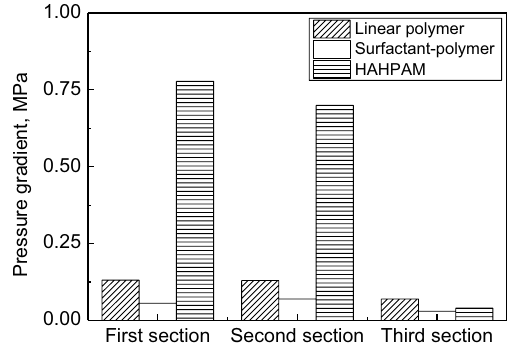
Fig. 12 Maximum pressure gradients of three sections for linear poly- mer, surfactant–polymer, and HAHPAM (permeability = 600 mD, salinity = 9000 mg L −1 , [Ca 2+ ] + [Mg 2+ ] = 9000 mg L −1 , T = 65 °C, concentrations = 0.2 wt%, injected volume = 1 PV, injected rate = 0.5 mL min −1